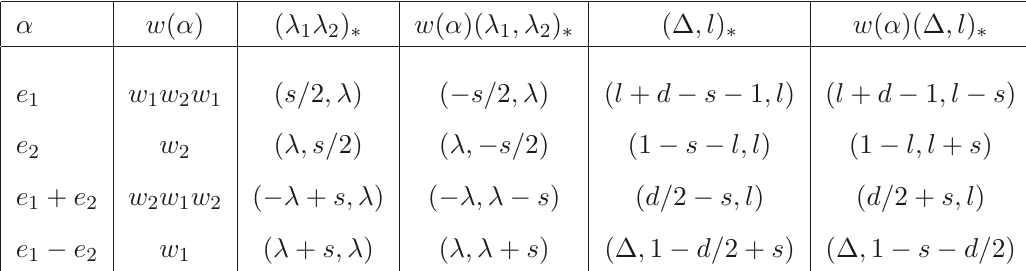
Table 2 . Pole positions (first column) and asymptotic data of their residues (second column) of the Harish-Chandra functions Φ( λ 1 , λ 2 , k ; z ) for N = 2. The third and forth column contain the same information in a different parametrization of asymptotic data, see section